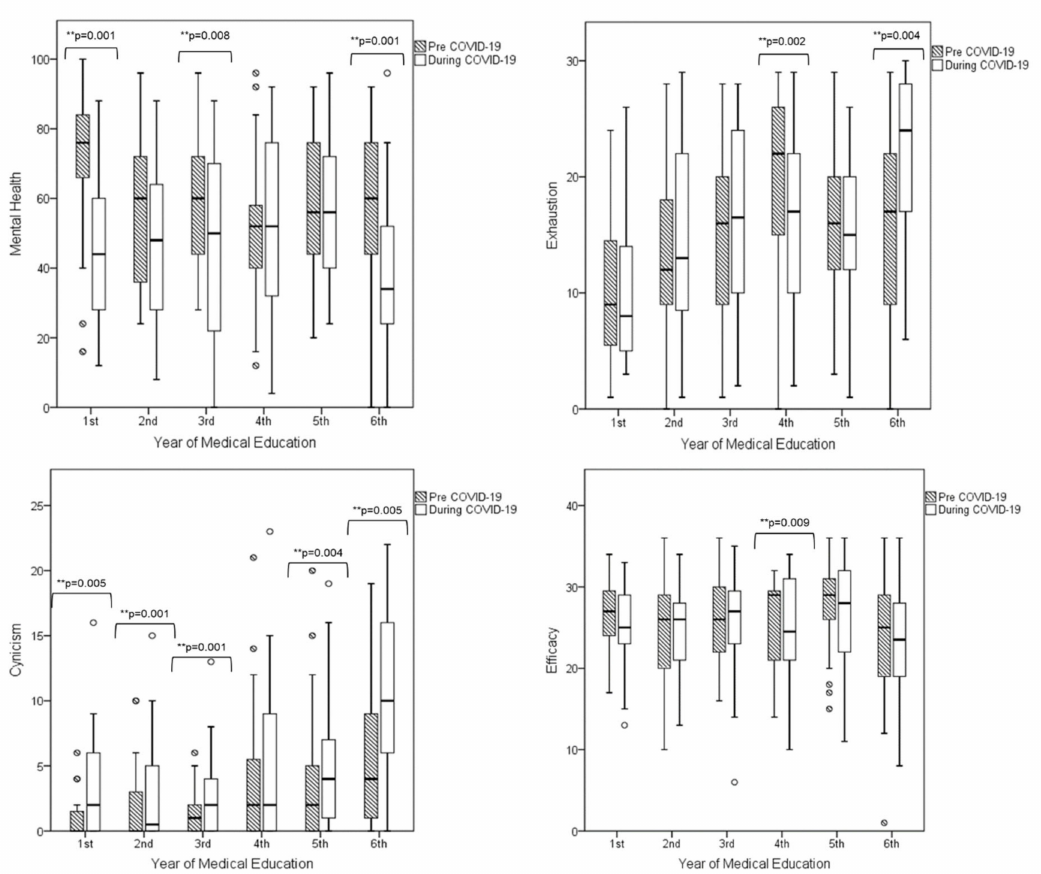
Figure 1. Changes observed in Maslach Burnout Inventory Student Survey dimensions and overall mental health after implementing digital